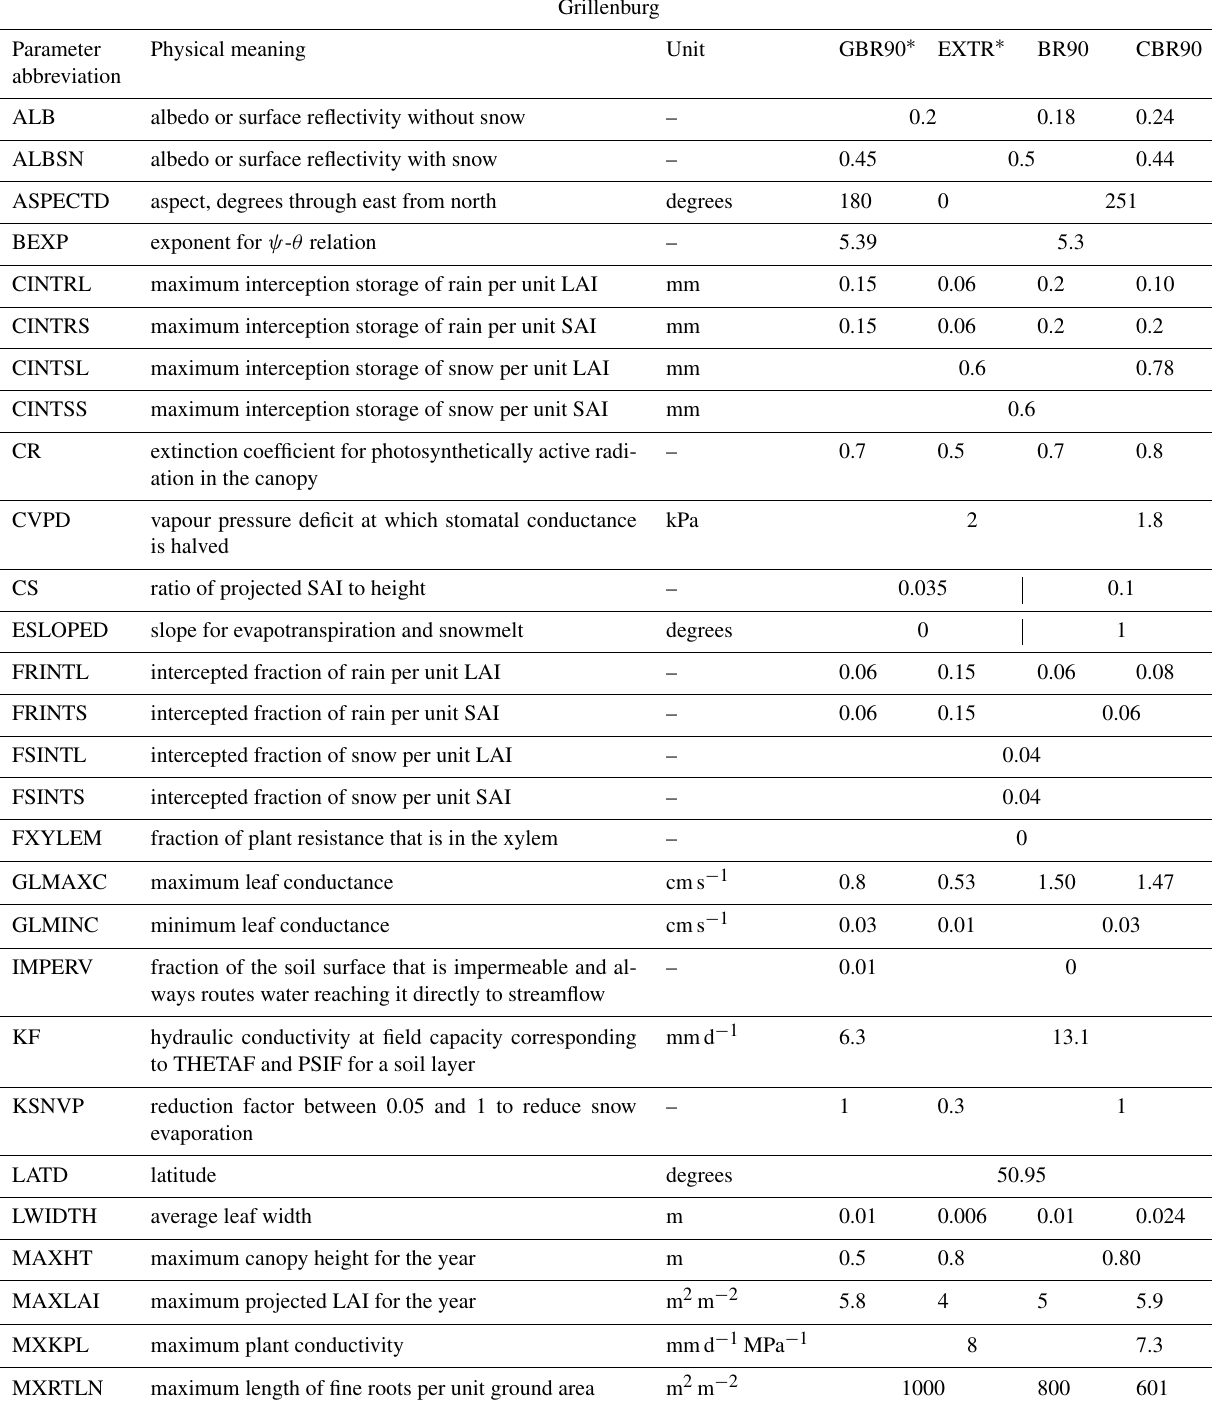
Table C1. Main site-specific parameters (topography, coil and land cover related) used in tested BROOK90 frameworks. SAI – stem